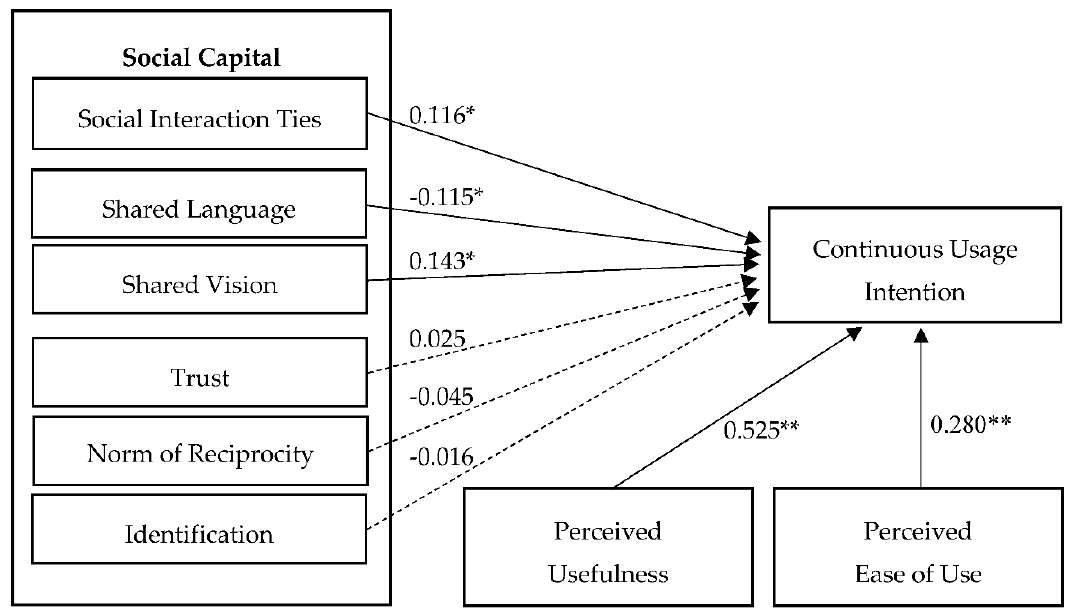
Figure 2. The results of regression analysis (* significant at p < 0.05; ** significant at p < 0.01). Table 9. The established hypotheses. Hypothesis Condition Hypothesis